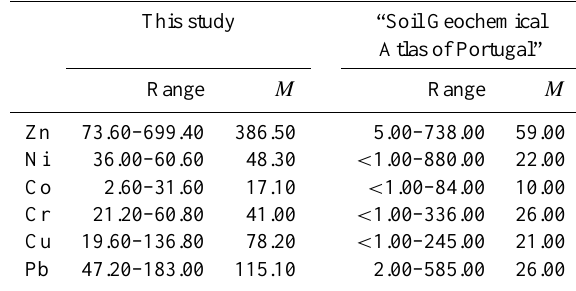
Table 4. The values of this study versus the values of the “Soil Geochemical Atlas of Portugal”.